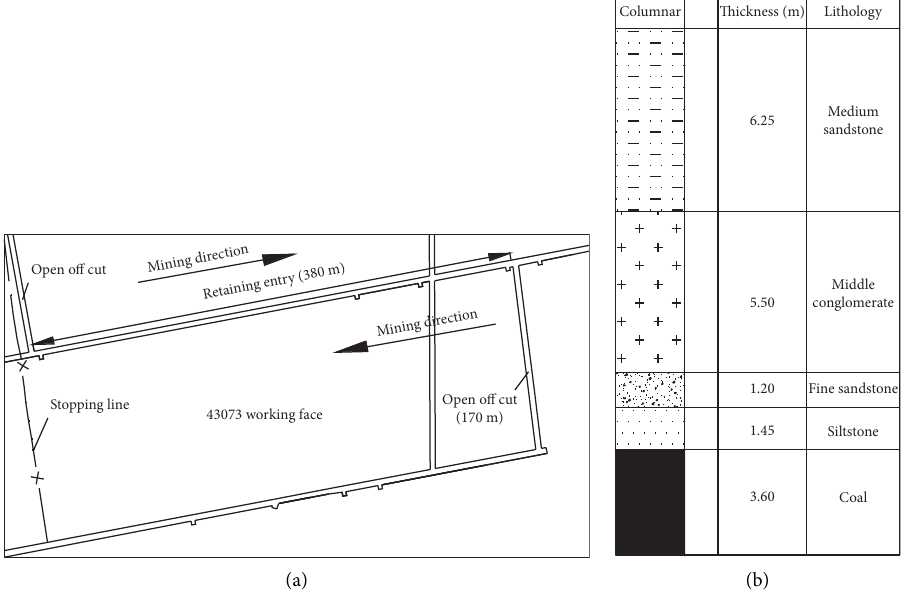
Figure 2: Layout and roof lithology of the 43073 working face. (a) Layout of the working face. (b) Lithological profile.